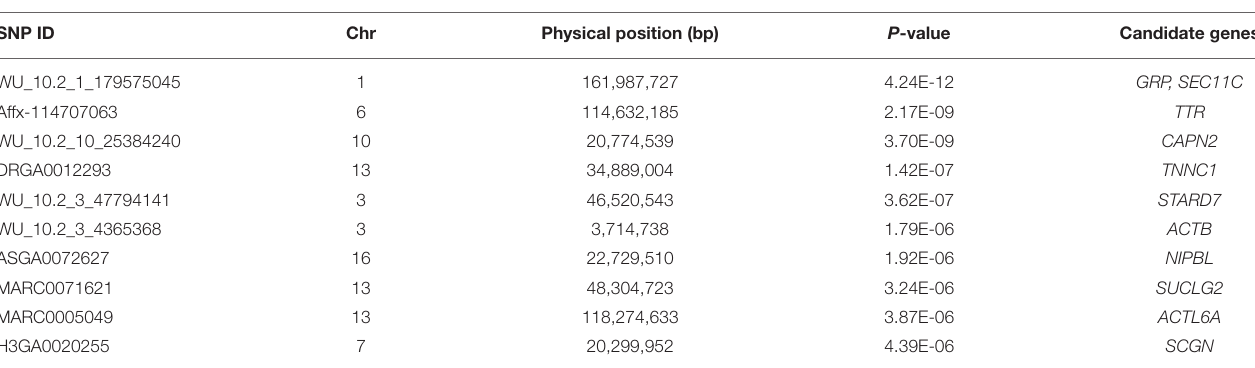
TABLE 3 | Summary information of top 10 significant SNPs for ADG